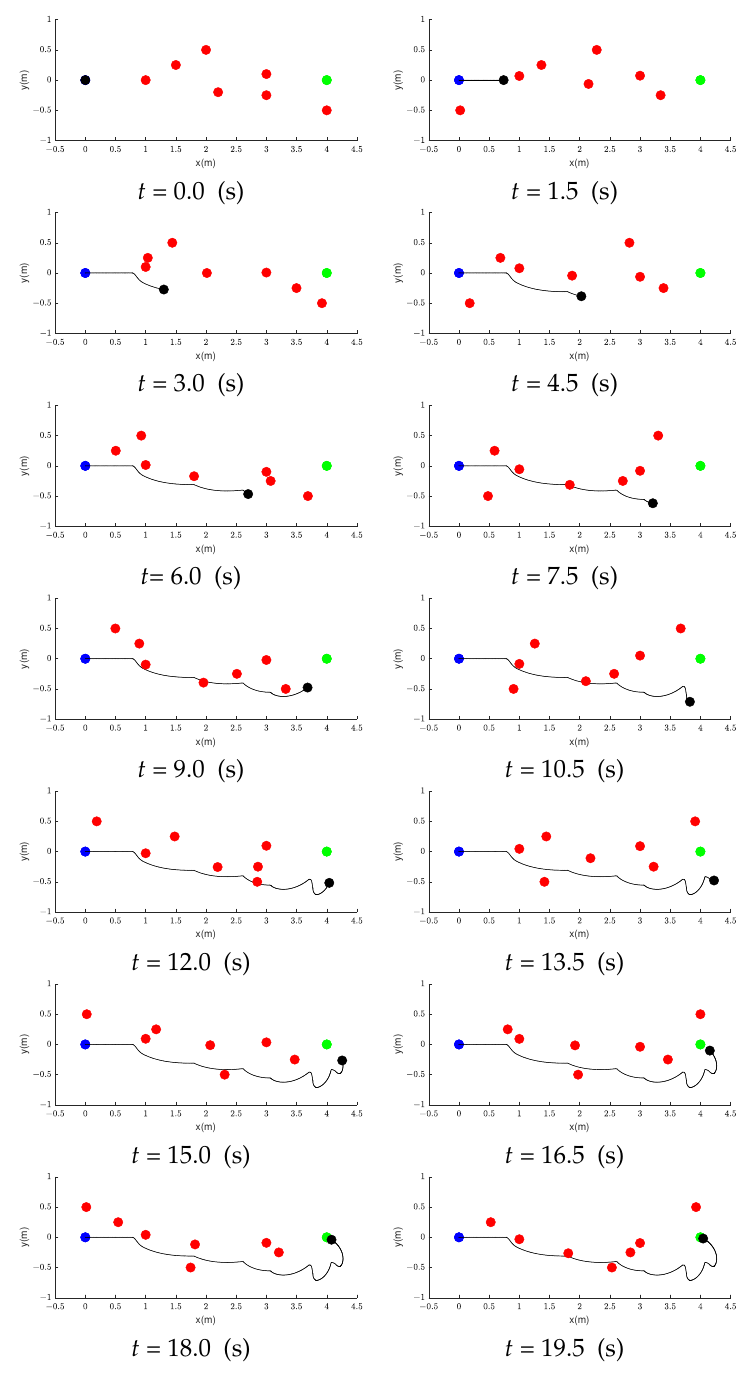
Figure 5. Behavior of Bug0 − for an arbitrary run. The complete scenario is shown every 1.5